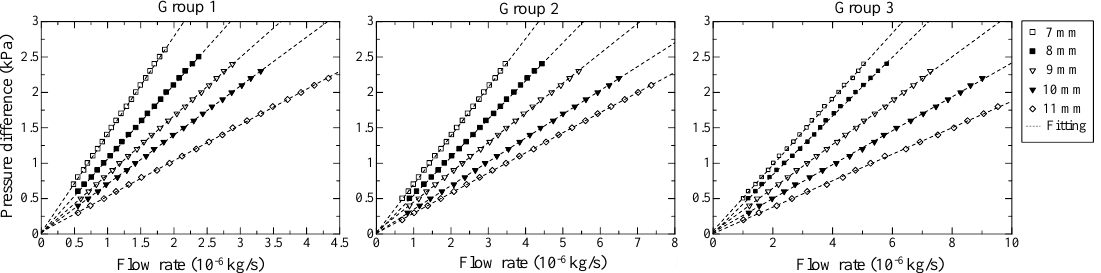
Figure 7. Variation of measured pressure difference with mass flow rate under small pressure drops (<3 kPa).